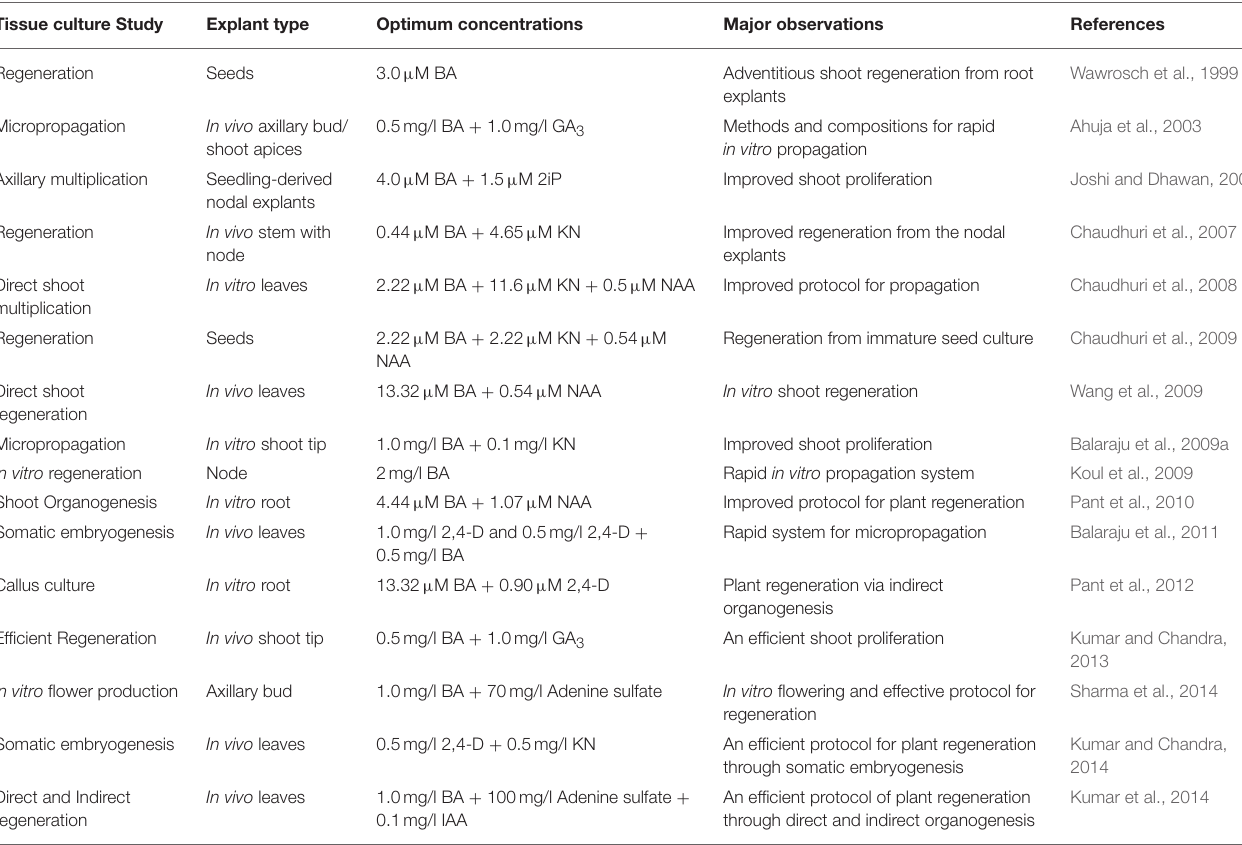
TABLE 5 | Micropropagation data for Swertia chirayita